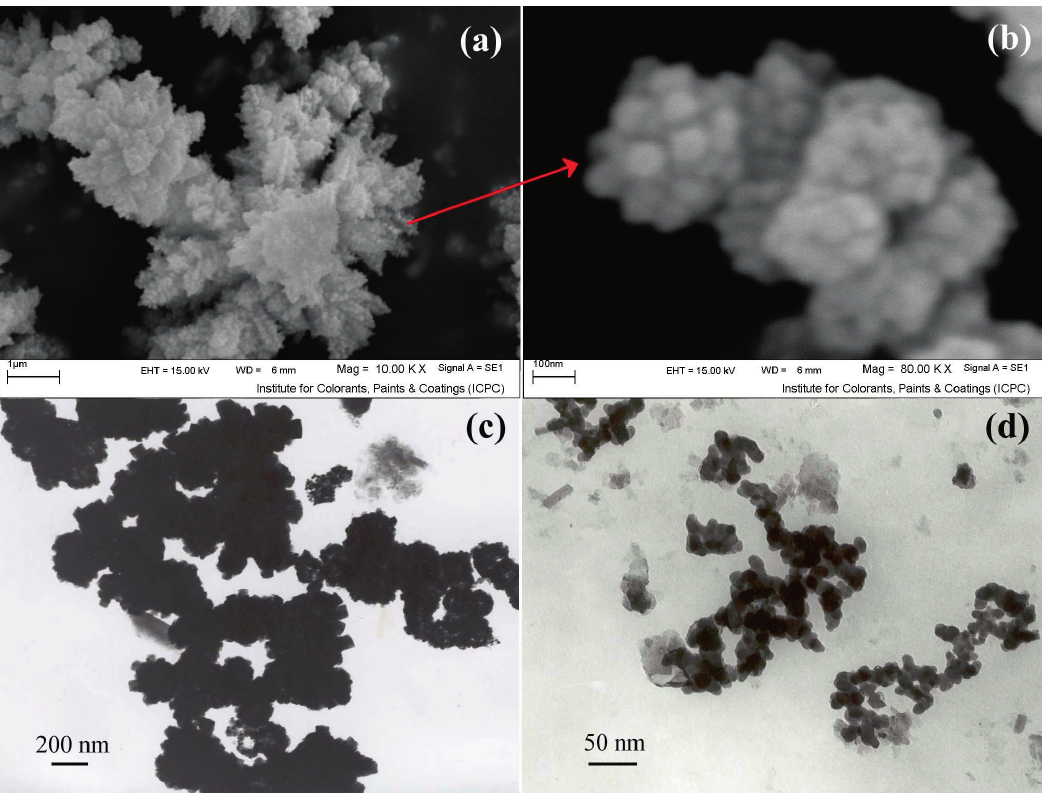
Figure 3. (a), (b) SEM and (c), (d) TEM images of CdS flower-like